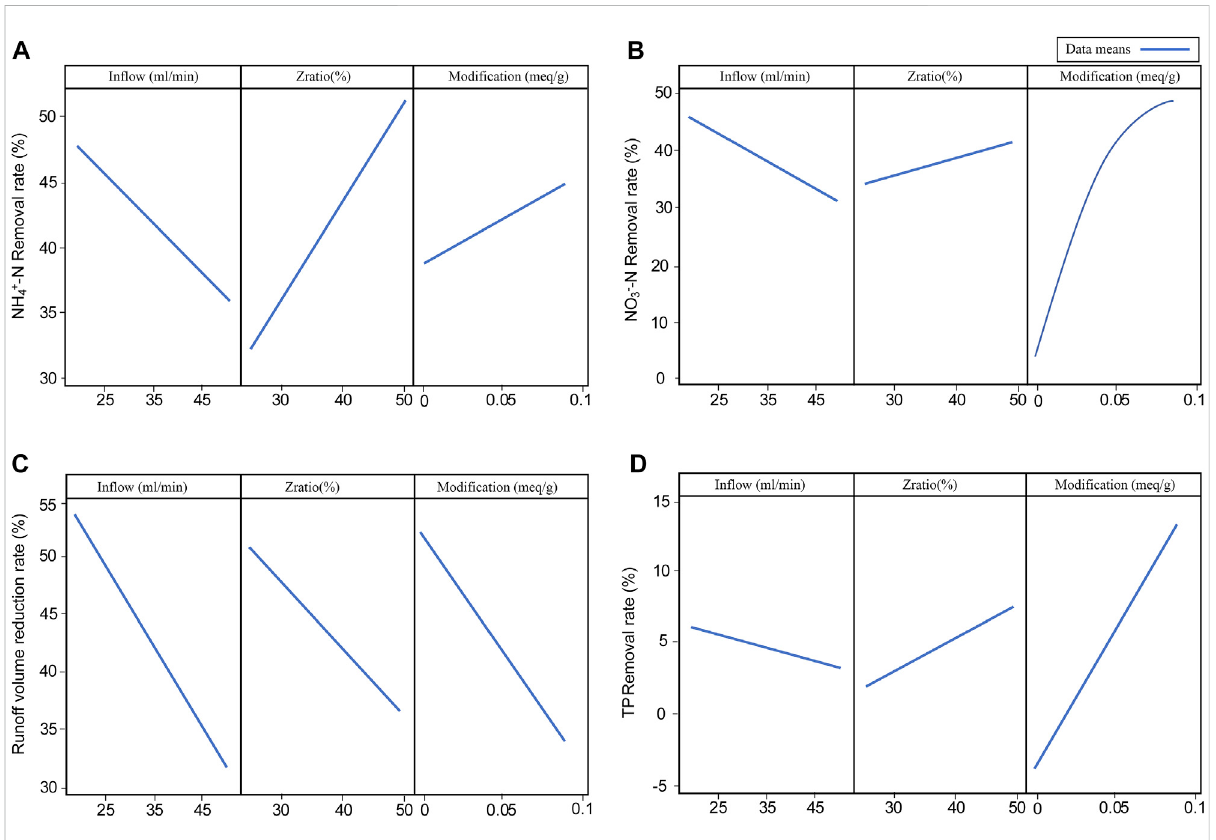
FIGURE 6 Maineffectplotfordifferentresponsevariables (A) maineffectplotforNH 4 + -Nremovalrate, (B) maineffectplotforNO 3 − removalrate, (C) main effect plot for runoff volume reduction, and (D) main effect plot for TP removal